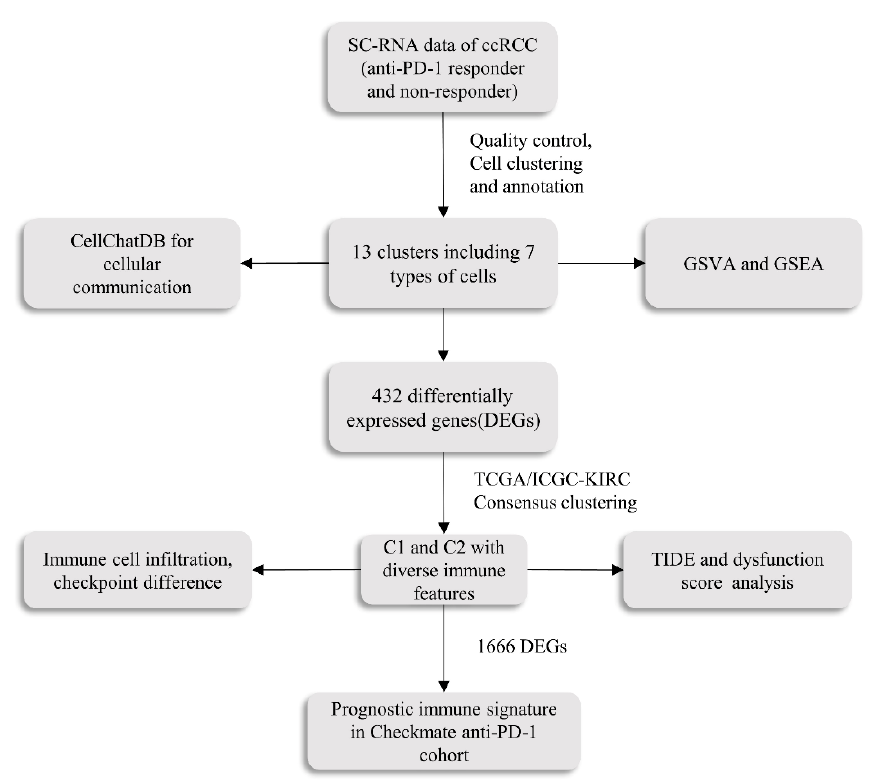
Figure 8. The overall workflow of the study. The scRNA-seq data were obtained from two patients who underwent cytoreductive nephrectomy after anti-PD-1 treatment (one was responsive to nivolumab and the other was nonresponsive), the prognostic immune signature (PIS) was established and verified in 172 patients (133 non-responders, 39 responders) with anti-PD-1 treatment. SC-RNA, single-cell RNA; ccRCC, clear cell renal cell carcinoma; GSVA, Gene Set Variation Analysis; GSEA, Gene Set Enrichment Analysis; TIDE score, Tumor Immune Dysfunction and Exclusion (TIDE) score.